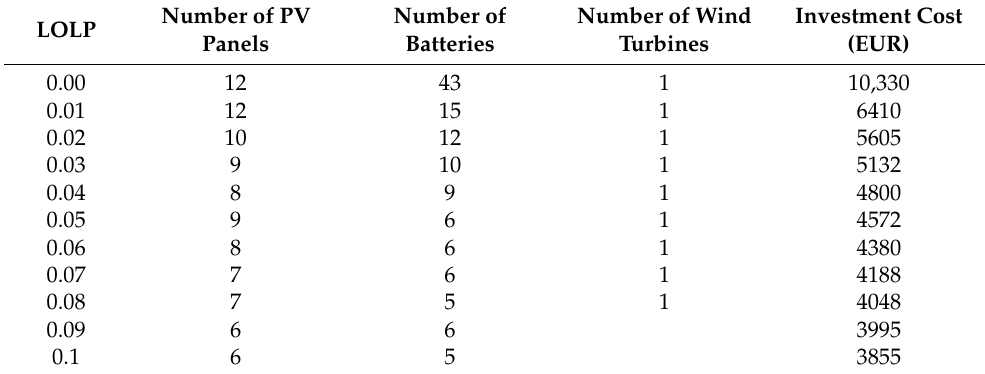
Table 5. Hybrid PV-wind battery system regarding LOLP and investment cost. LOLP